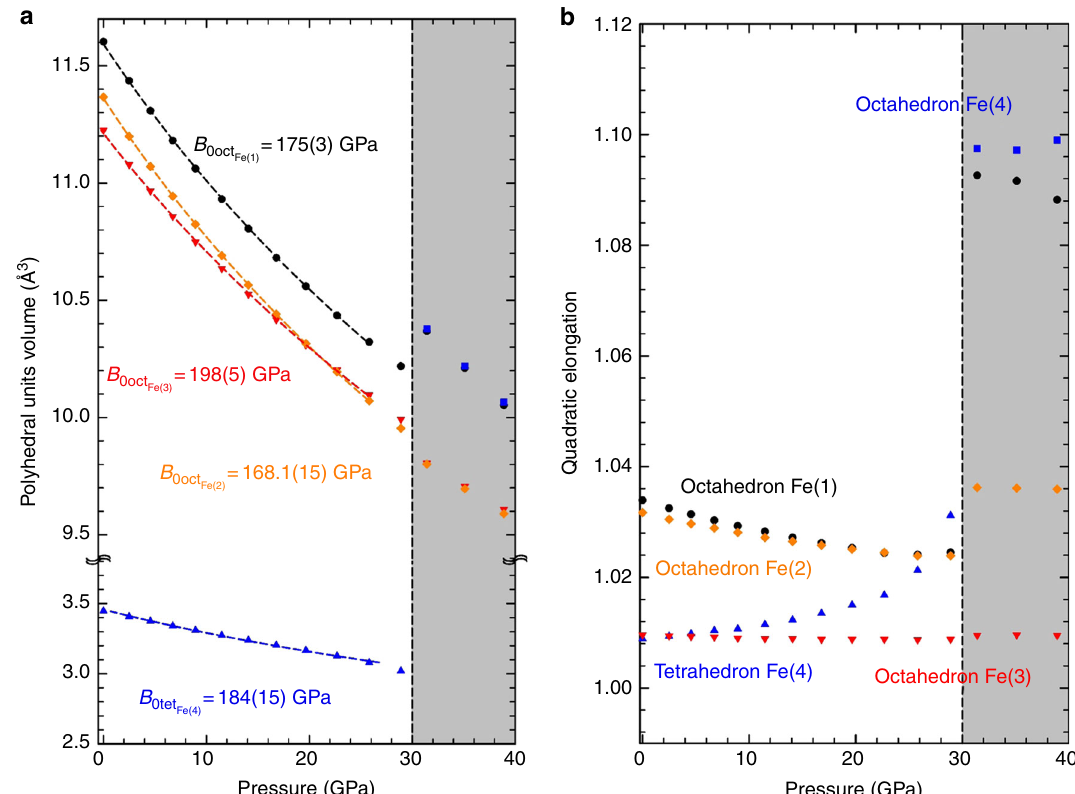
Fig. 3 Analysis of the volume and the quadratic elongation of the polyhedral units under pressure. Representation of the evolution under compression of theoretically simulated a polyhedral unit volume and b quadratic elongation of polyhedral units around Fe(1) (black circle), Fe(2) (green diamond), Fe(3) (red triangle down) and Fe(4) (blue triangle up before 40 GPa and blue square after 30